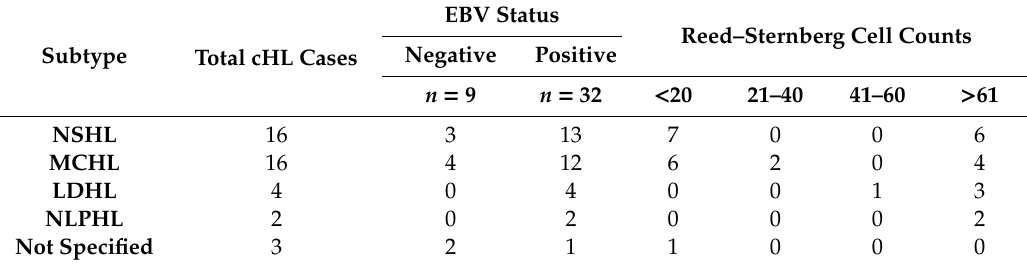
Table 1. Distribution of Epstein–Barr virus infection and Reed–Sternberg cell counts across cHL